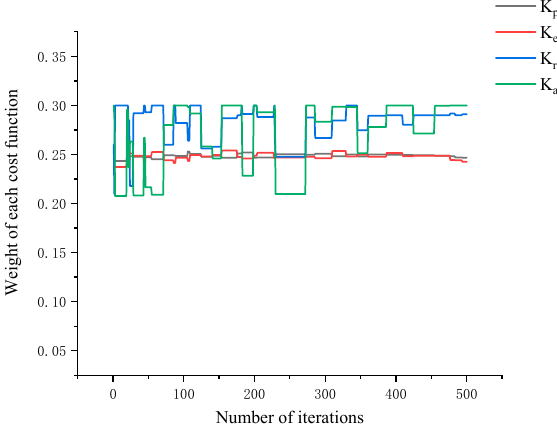
Figure 11. The weight of cost function of EPA-PSO algorithm after 200 iterations.